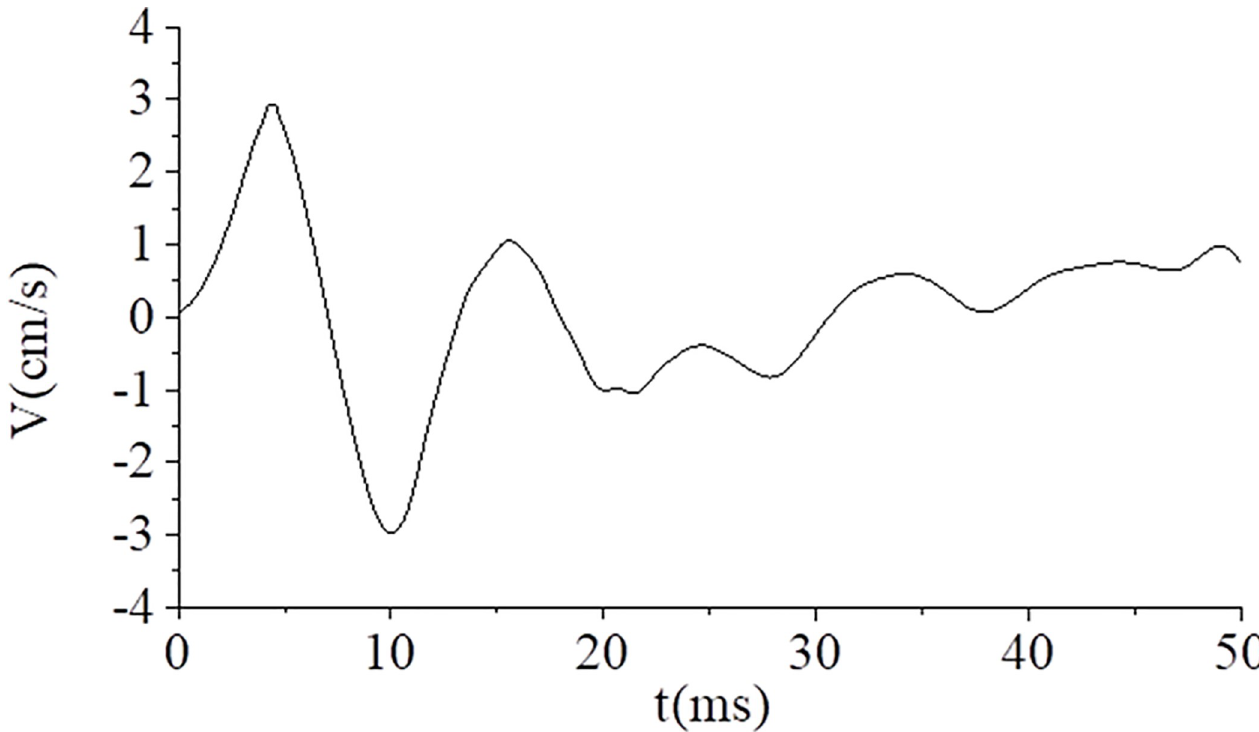
Fig 10. Vibration velocity curve of the blasting signal using non-electric detonators for Part I